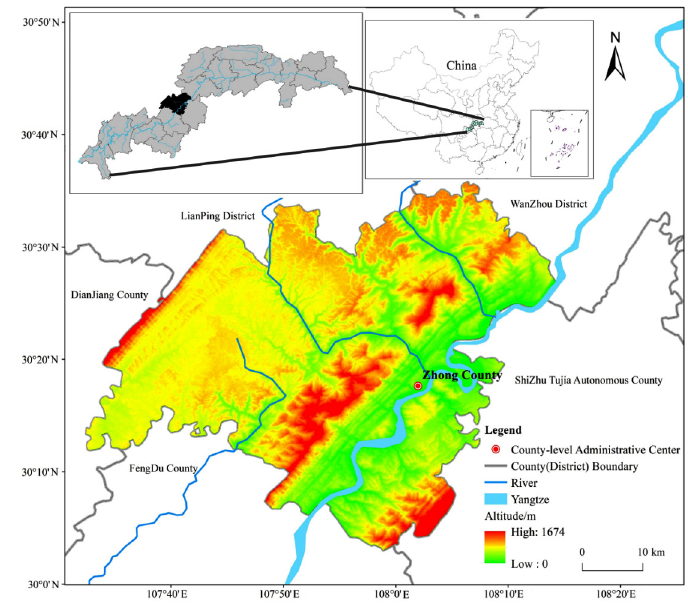
Figure 1. Geographic location of Zhong